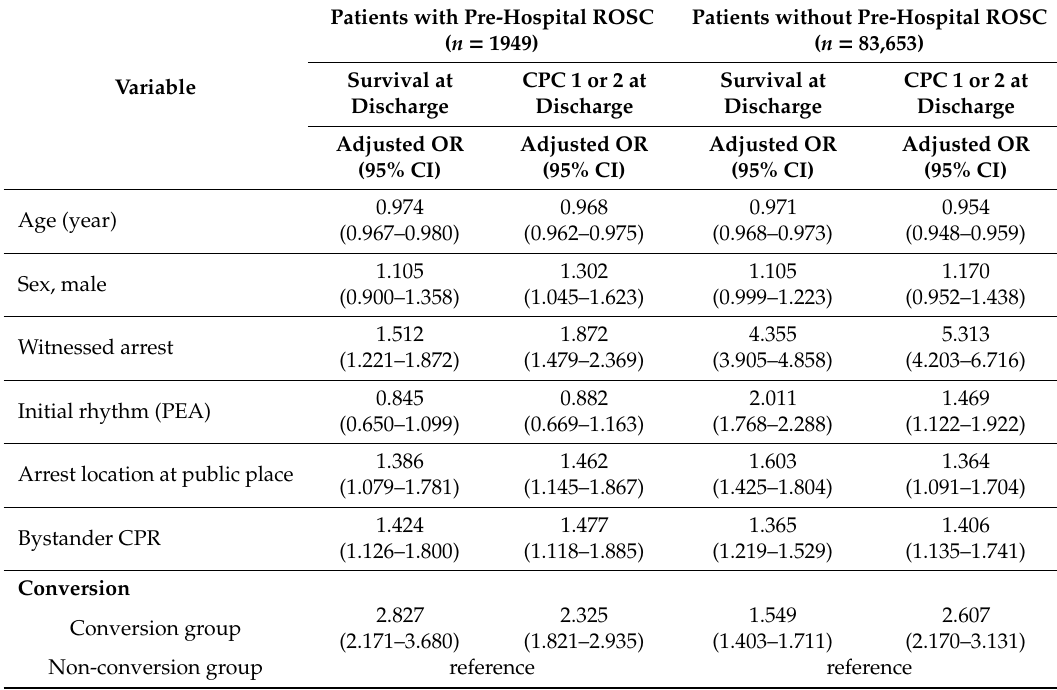
Table 5. Multiple logistic regression analysis for outcomes in OHCA patients with initial non-shockable rhythm according to pre-hospital